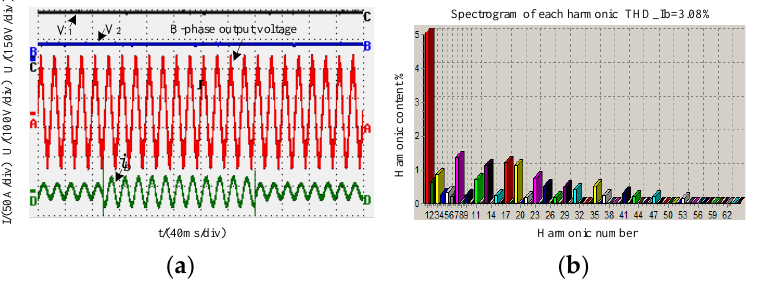
Figure 23. Compensated waveforms: ( a ) current of power grid; capacitor voltage and output voltage, ( b ) THD of B-phase